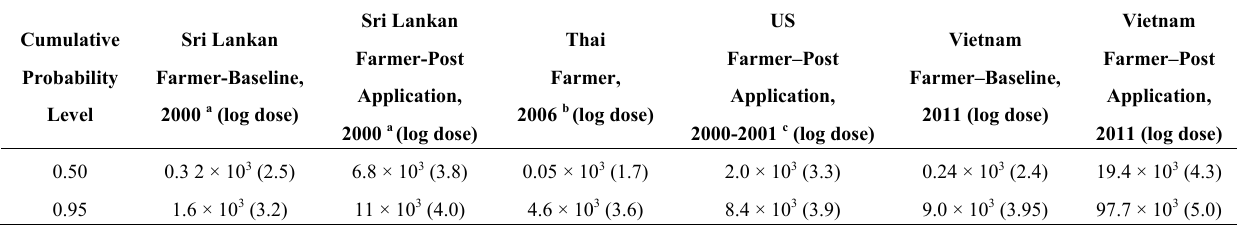
Table 3. Equivalent chlorpyrifos ingested dose (ECID, ng/kg/day) for farmers from various